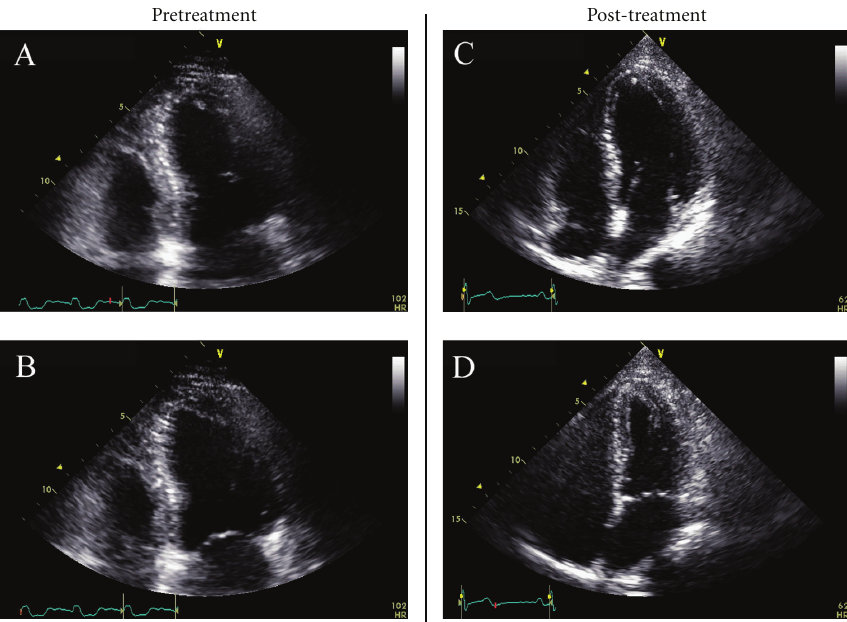
Figure 3: Transthoracic echocardiogram before and after treatment with IVIG and steroids. Apical 4-chamber view with pretreatment end diastole (A) and end systole (B) demonstrating severe global systolic dysfunction, LVEF < 20%. The repeat transthoracic echocardiogram before treatment prior to discharge end diastole (C) and end systole (D) demonstrating a near complete resolution of ventricular systolic dysfunction.